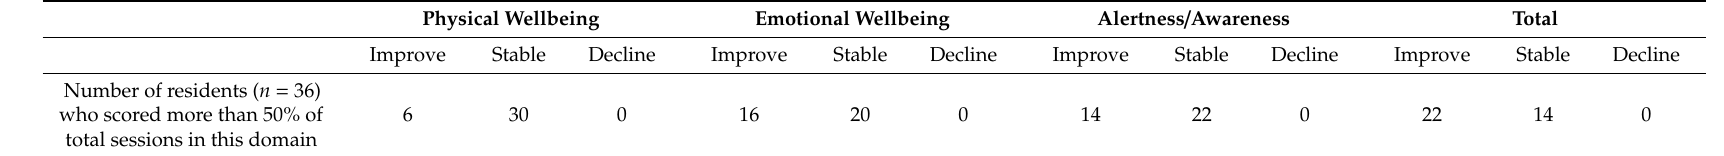
Table 9. Sta ff perceptions of resident wellbeing across all domains of NSQ